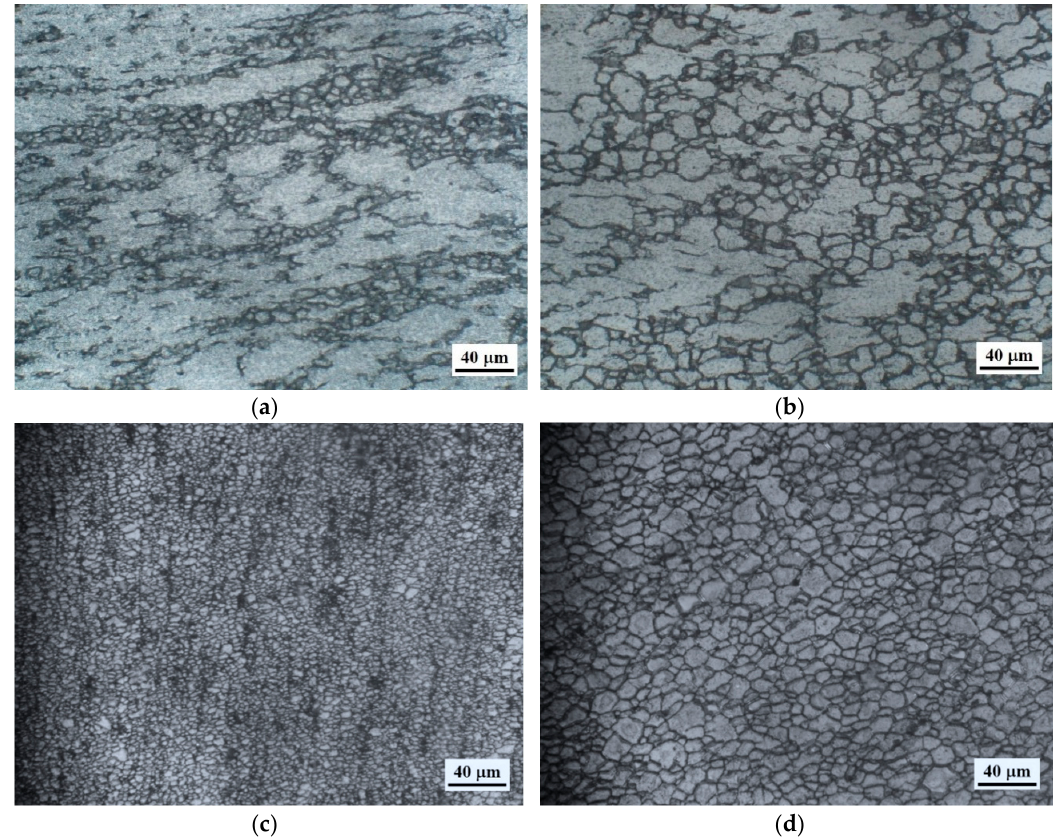
Figure 9. Dynamic recrystallized (DRX) microstructures obtained on as-cast AZ31-2Ca alloy in Domain #1 at ( a ) 400 ◦ C/0.0003 s − 1 ; ( b ) 450 ◦ C/0.0003 s − 1 ; and on DMD processed alloy in Domain #1A at ( c ) 350 ◦ C/0.0003 s − 1 and in Domain #1 at ( d ) 450 ◦ C/0.0003 s − 1